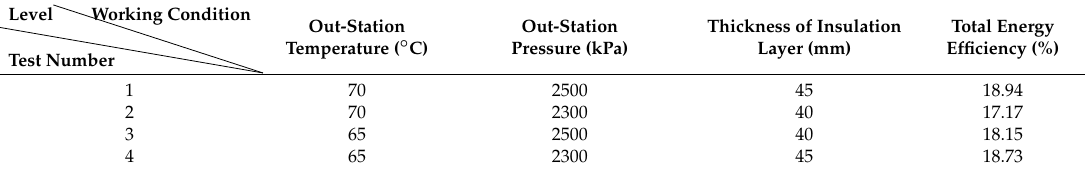
Table 3. The results of the orthogonal experiment.